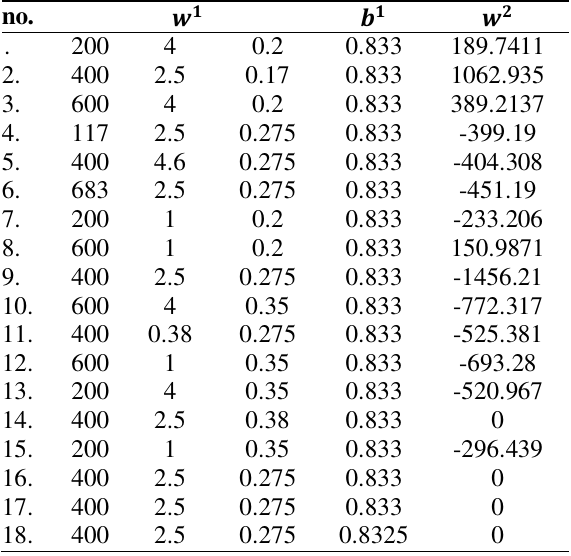
The network weights matrices and bias & "